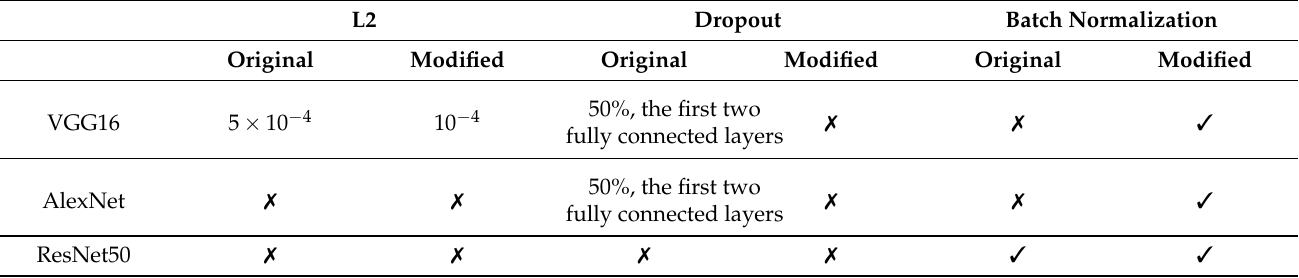
Table 1. Original and modified regularization parameters used by the convolutional neural networks.